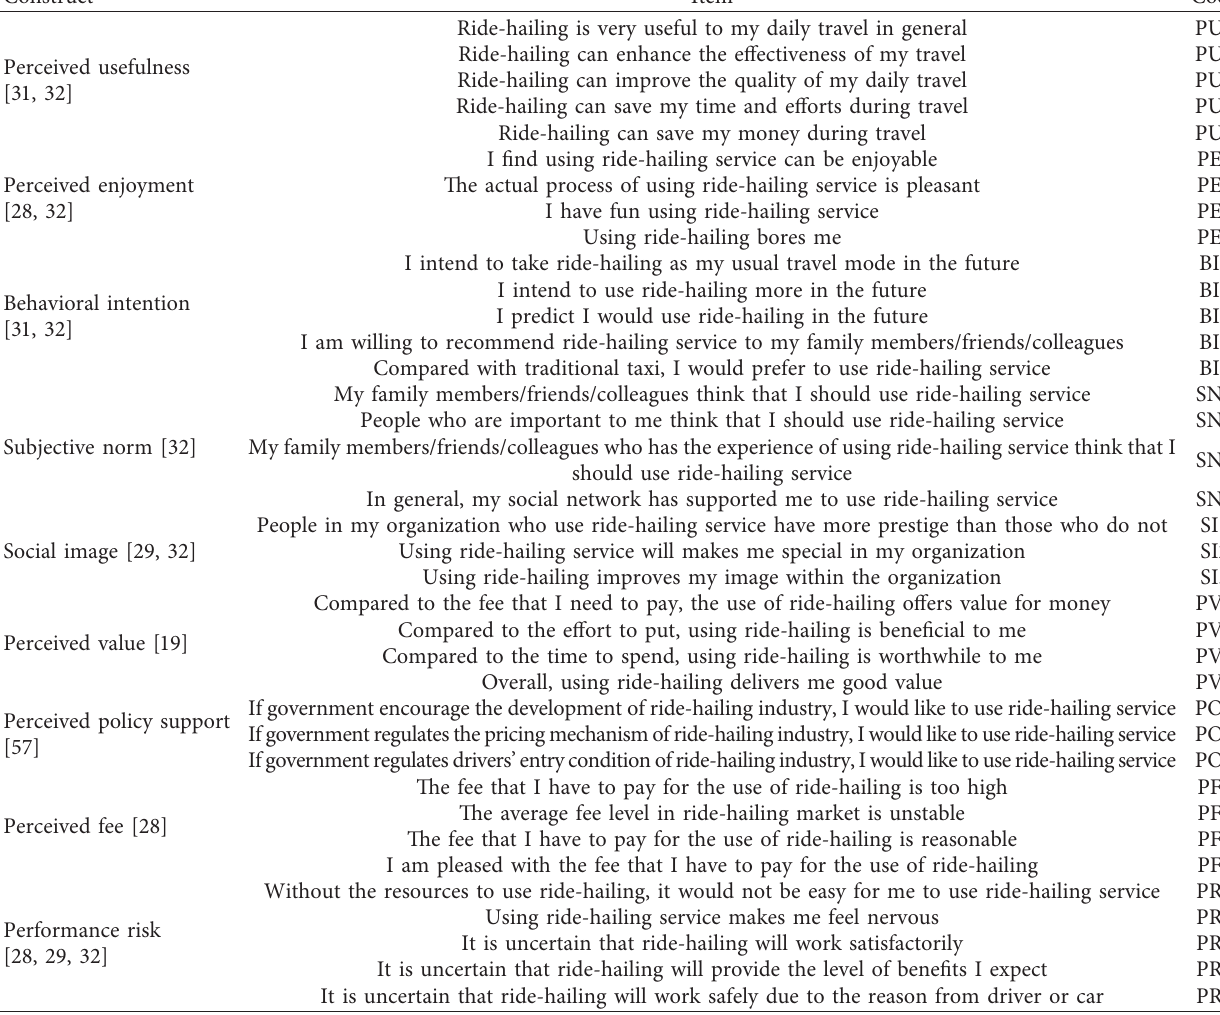
Table 2: Appendix: list of